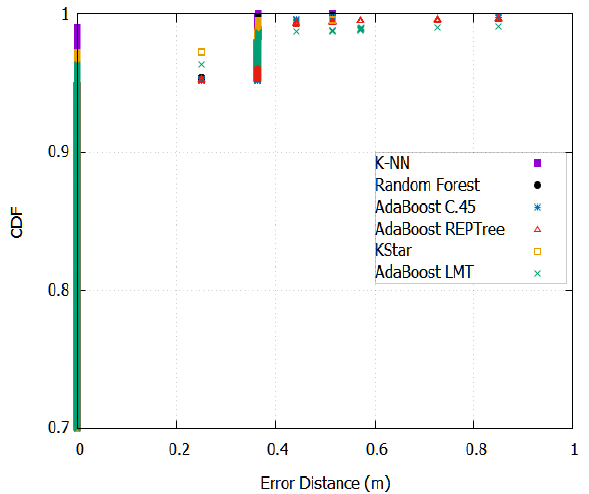
Figure 4. CDF of performance for the best analysed